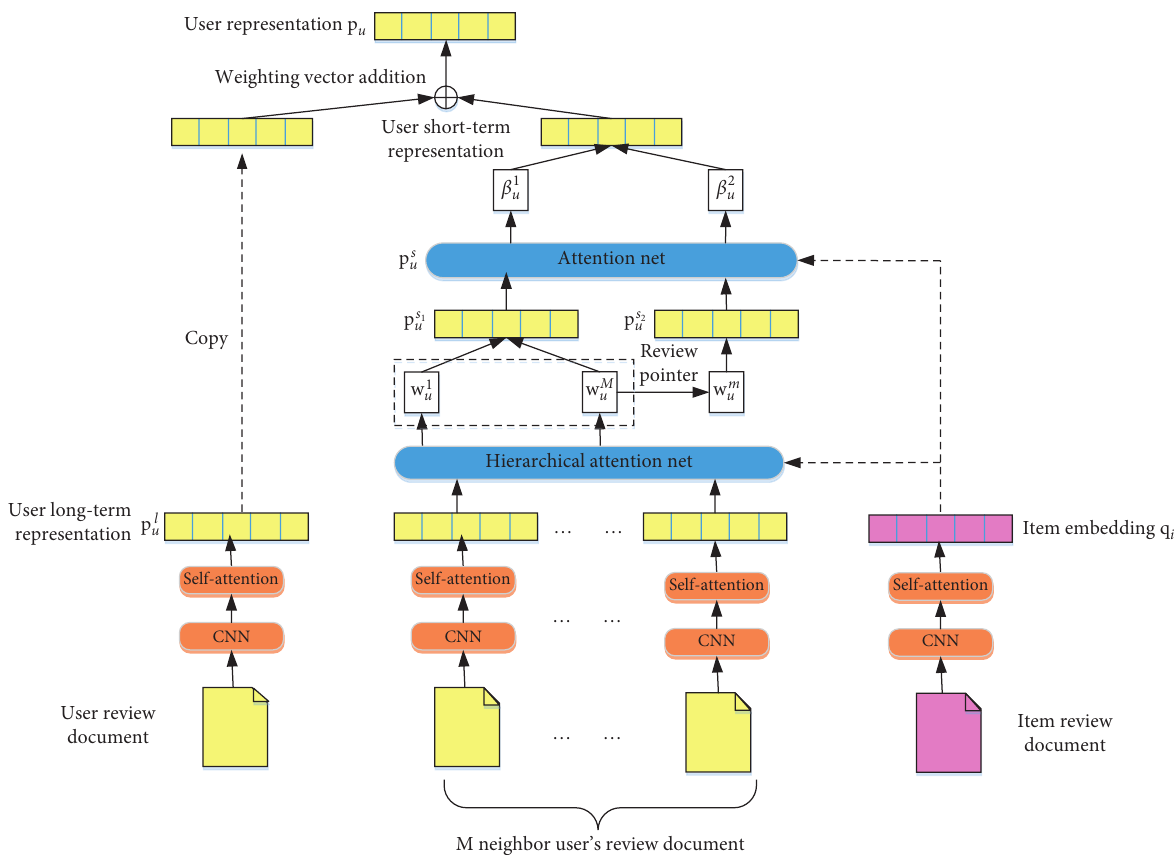
Figure 1: Network architecture of RANM.